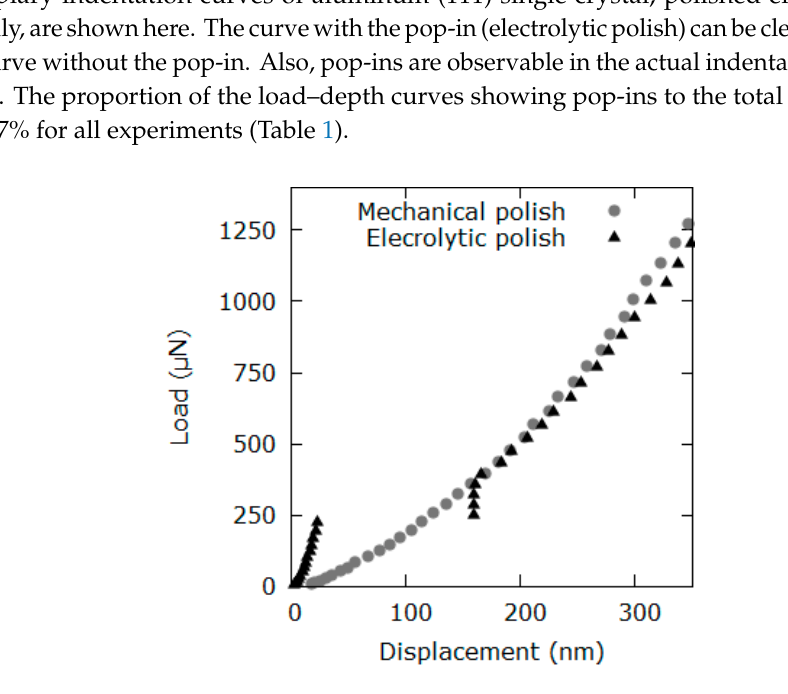
Figure 1. Load–displacement curve on the aluminum (111)-single-crystal surface, polished electrolytically (pop-in) and mechanically (no pop-in). Table 1. Proportion of the load–depth curves that exhibit pop-ins. The analysis is based on the curves from experiments on the influence of the crystal orientation and the azimuthal indenter